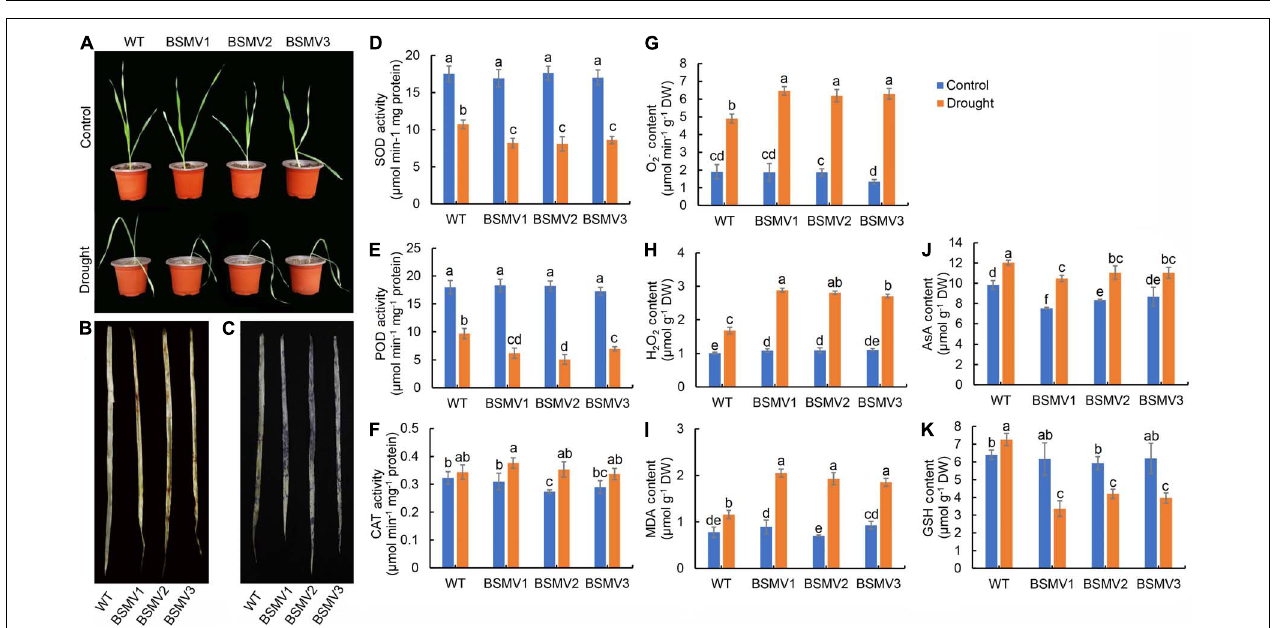
FIGURE 8 | Silencing of HvbZIP21 in EC_S1 by VIGS-BSMV. (A) Photo of WT and BSMV: HvbZIP21 -inoculated plants; (B) DAB staining of leaves of WT and BSMV:HvbZIP21-inoculated plants; (C) NBT staining of leaves of WT and BSMV:HvbZIP21-inoculated plants; (D) SOD activity; (E) POD activity; (F) CAT activity; (G) AsA content; (H) GSH content; (I) O 2 - content; (J) H 2 O 2 content; (K) MDA content. Different lowercase letters indicate significance levels at P ≤ 0.05 ( n = 3 independent replicates).